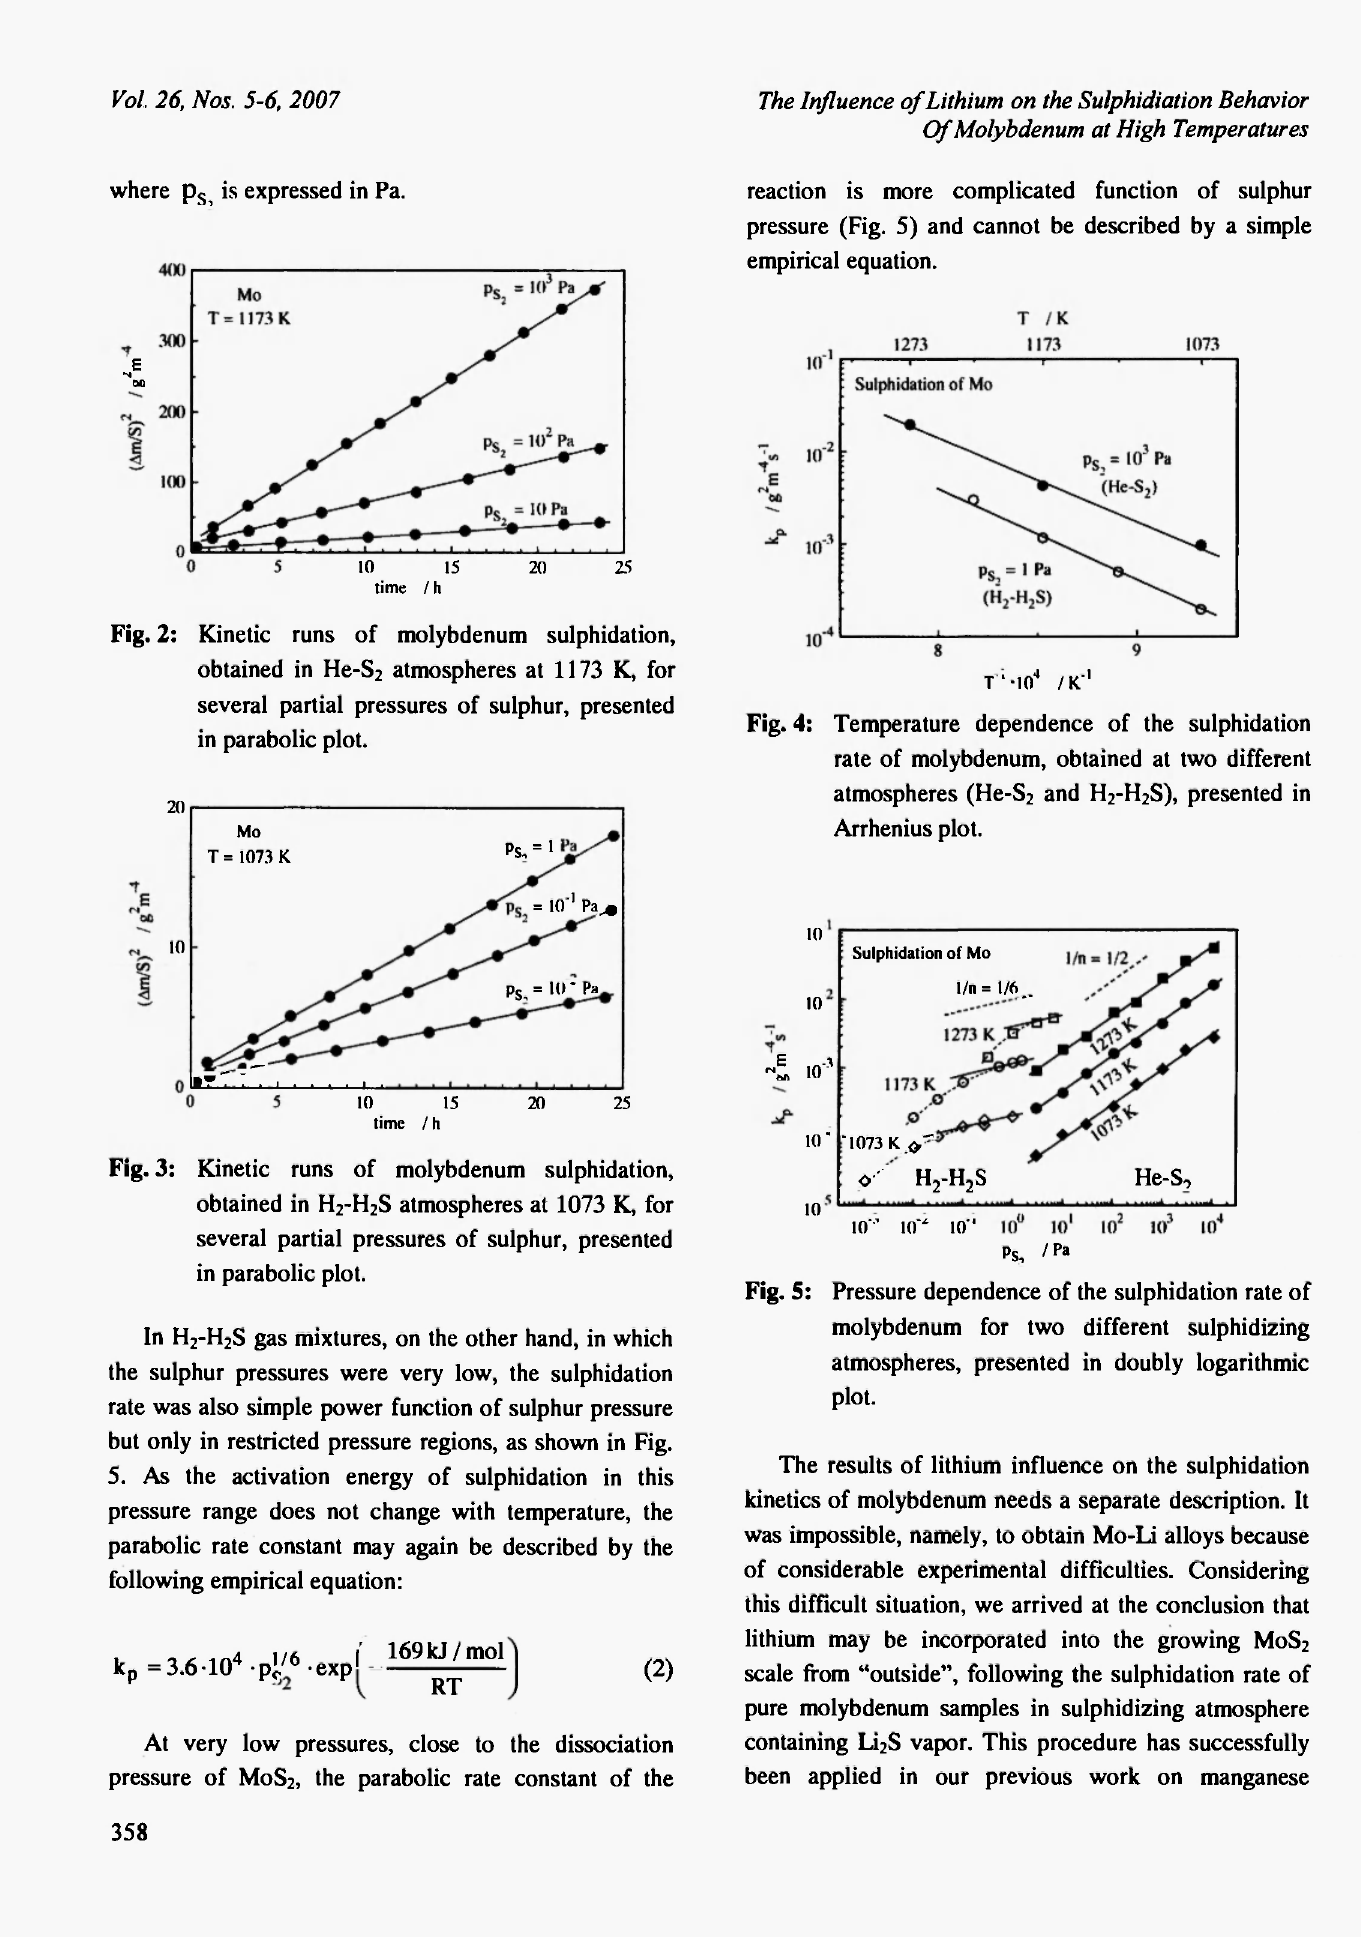
Fig. 5: Pressure dependence of the sulphidation rate of molybdenum for two different sulphidizing atmospheres, presented in doubly logarithmic